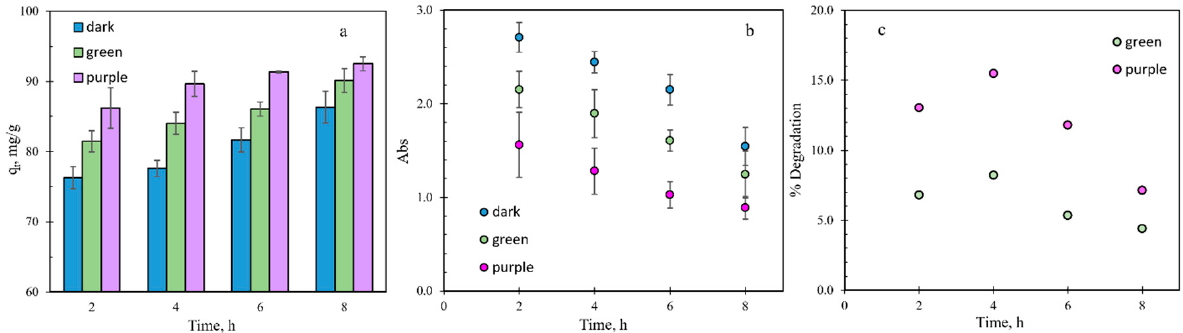
Figure 5. ( a ) The amount of MB removed over time, in the dark and under green and purple light, ( b ) MB filtrate absorbance over time, in the dark and under green and purple light, ( c ) % degradation over time under green and purple light.